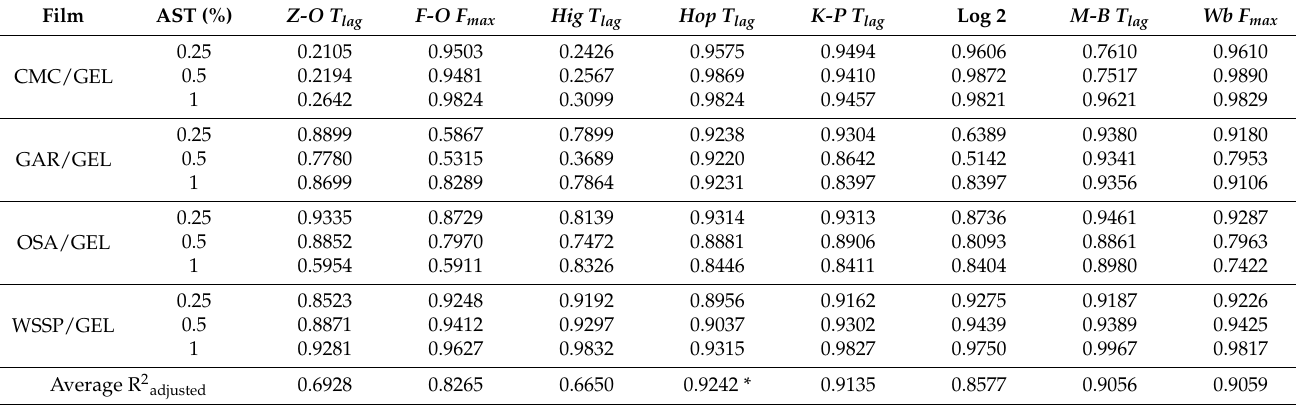
Figure 4. Percentage release of AST from the binary polysaccharide/GEL blend films into the water at 25 °C. Table 3. Comparison of R 2 adjusted values obtained from fitting experimental data to the different release